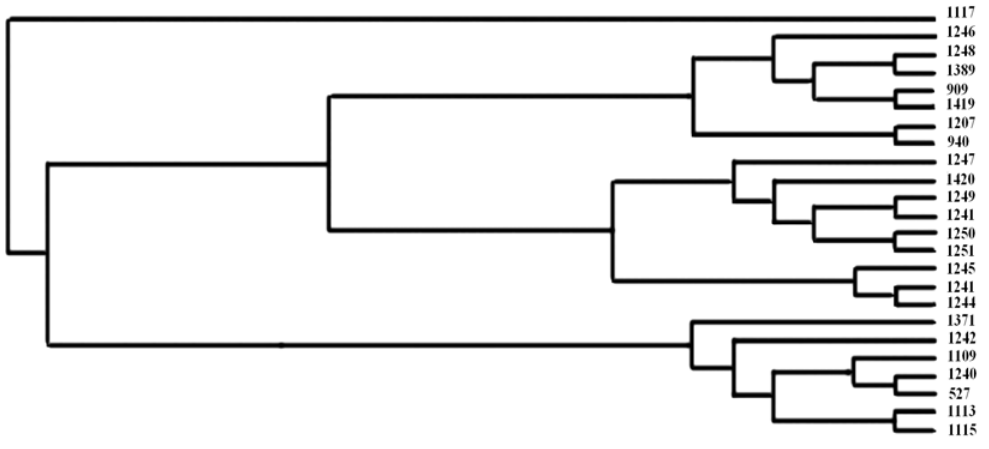
F IG .3.- Dendrogram showing relationship between Meriones species. (1117) T. indica , (1246 to 1244) M. libycus , (1371) M. crassus , (1424 to 1115) M. persicus